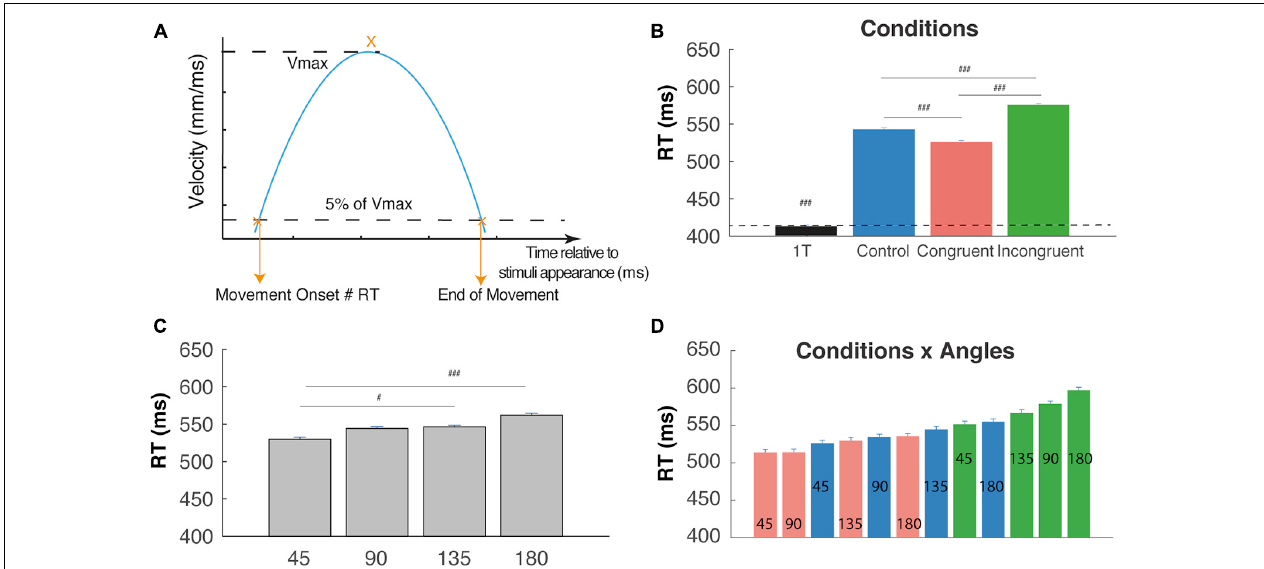
FIGURE 2 | Reaction time (RT). (A) RT corresponds to the movement onset time relatively to the appearance of the cues; it is defined by the time at which the velocity cross a threshold defines as 5% of the maximal tangential velocity (Vmax). (B) RT are significantly shorter for the one-target condition in comparison with two targets cognitive conditions. RT trials are significantly longer than control and congruent trials RTs (interference effect) and Congruent trials are faster than control trials (congruency effect) (### P < 0.0001). (C) RT increase with the angular distance between targets. (D) Almost linear increase of RT when considered the (12) conditions x angles trial types and revealing a continuum in the competition level induced by these trials-types. # p <